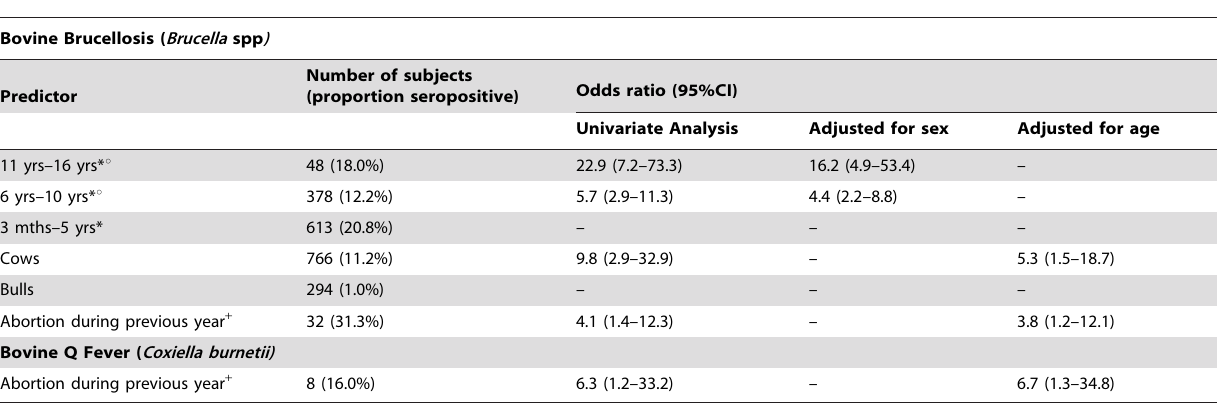
Table 3. Predictors of seropositivity to Brucella spp and Coxiella burnetii by ELISA in cattle.